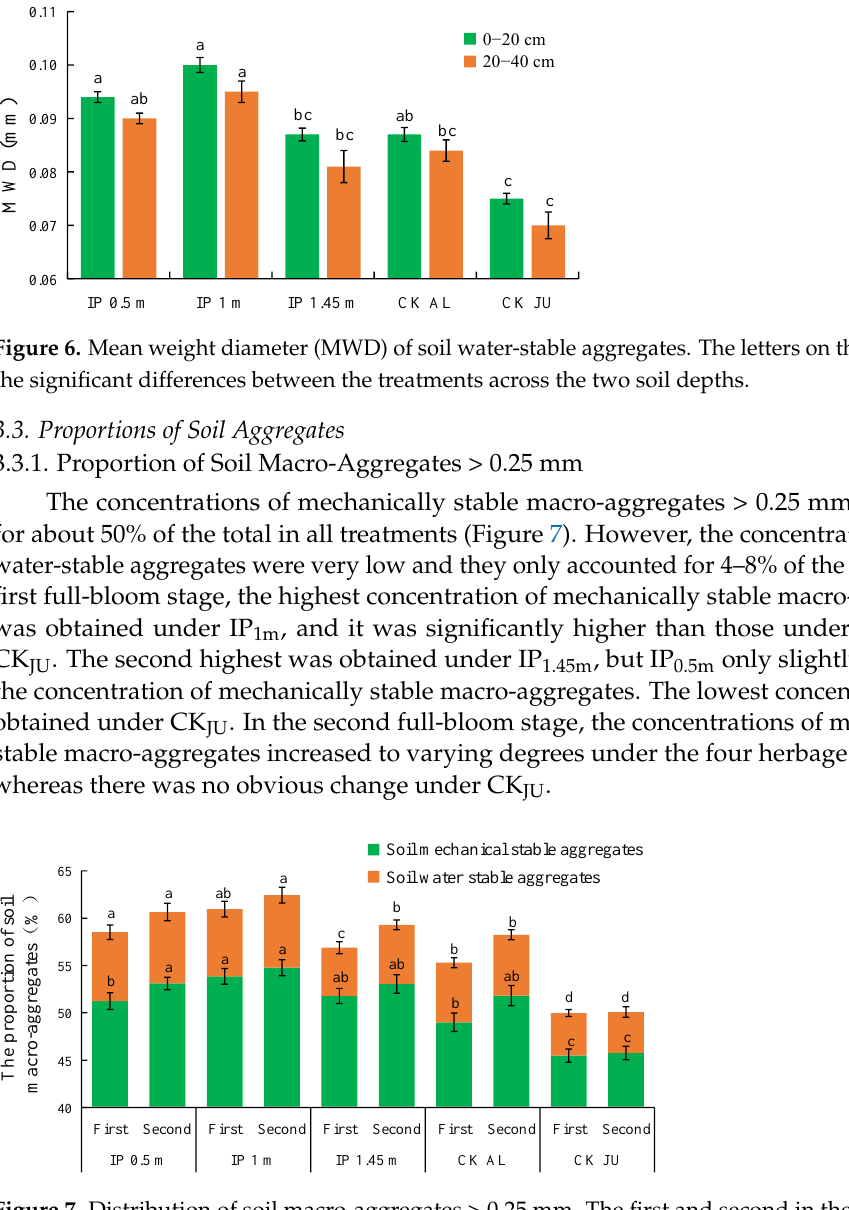
Figure 7. Distribution of soil macro-aggregates > 0.25 mm. The first and second in the abscissa are the abbreviation of the first full-bloom stage and the second full-bloom stage, respectively.